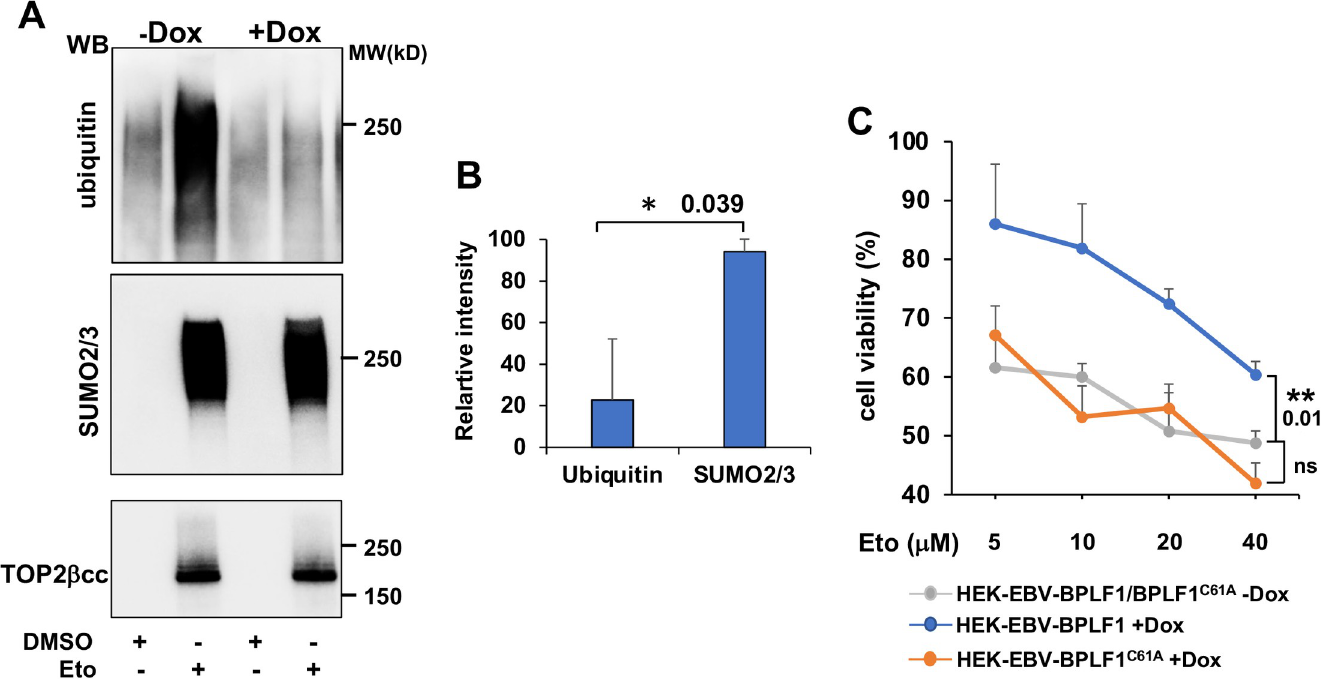
Fig 4. BPLF1 promotes the accumulation of SUMOylated TOP2ccs and cell viability following Etoposide treatment. (A) HEK-rtTA-BPLF1 cells were cultured for 24 h in the presence or absence of 1.5 μ g/ml Dox and then treated with 80 μ M Etoposide for 30 min followed by detection of DNA trapped TOP2 by RADAR assay. Western blots of proteins bound to 10 μ g DNA were probed with antibodies to TOP2, ubiquitin and SUMO2/3. The expression of BPLF1 was associated with strongly decreased ubiquitination of the TOP2ccs while SUMOylation was only marginally affected. (B ) The intensity of the ubiquitin/SUMO2/3 smears and TOP2 specific bands was quantified by densitometry using the ImageJ software. Relative intensity was calculated as intensity of the smears in Dox-treated versus untreated cells after normalization to the total amount of DNA-tapped TOP2. Mean ± SE of two independent experiments. Statistical analysis was performed using Student’s t-test. � P � 0.05. ( C ) HEK-rtTA-BPLF1/BPLF C61A cells were cultured for 24 h in the presence or absence of 1.5 μ g/ml Dox and then treated overnight with the indicated concentration of Etoposide before assessing cell viability by MTT assays. The expression of catalytically active BPLF1 decreased the toxic effect of Etoposide over a wide range of concentrations while BPLF1 C61A had no appreciable effect. The mean ± SD of two independent experiments is shown. Statistical analysis was performed using Student’s t-test. �� P � 0.01; ns = non-significant.